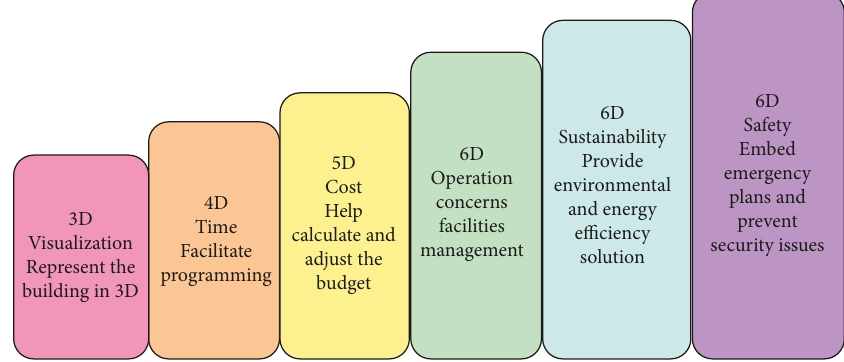
Figure 7: BIM dimensions (adapted from the work of Smith